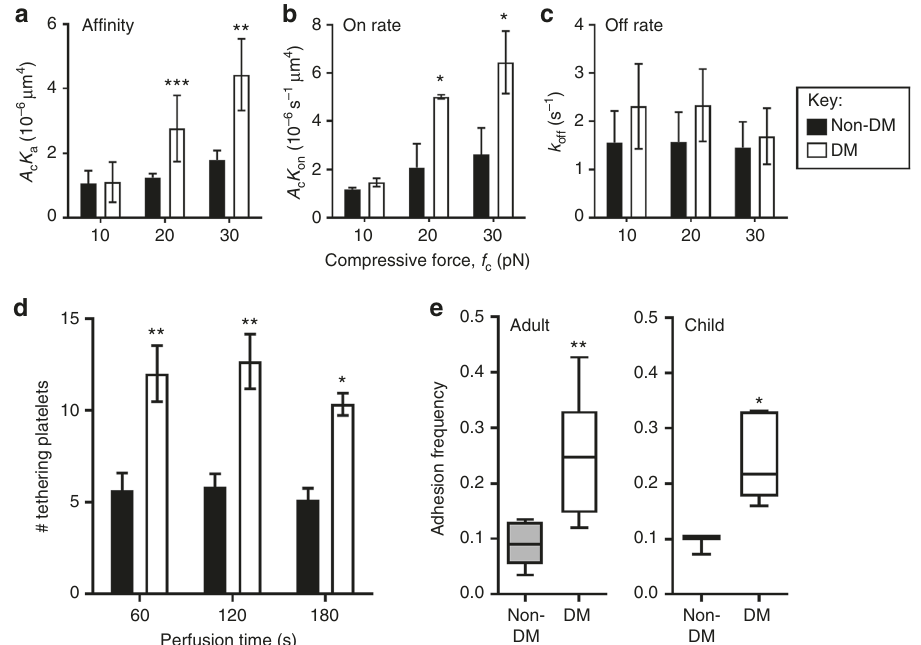
Fig. 5 Compressive forces enhance integrin α IIb β 3 – fi brinogen bond formation in diabetic platelets. a – c Platelets from non-DM and DM mice were subjected to BFP cycles using FGN-coated beads at various contact times to determine the 2D af fi nity ( a ), on-rate ( b ) and off-rate ( c ) of integrin α IIb β 3 at f c = 10, 20 and 30 pN, as detailed under Methods section. d Hirudinated whole blood from non-DM or DM mice were perfused over FGN matrices at 600 s − 1 , and the number of tethered platelets at the indicated perfusion times was quanti fi ed. Results are expressed as mean ± s.e.m. of n = 3 – 4 mice. e Human platelets from non-DM and DM adults or children were subjected to 50 BFP cycles using beads coated with FGN at f c = 20 pN, and adhesion frequency determined. Data are represented in box and whisker plot format, with median, fi rst and third quartiles outlined by the box, and minimum and maximum values of the data set denoted by whiskers ( n = 7 for both non-DM and DM adults; n = 3 for non-DM children; n = 5 for DM children) * p < 0.5; ** p < 0.01, assessed by unpaired, two-tailed Student ’ s t